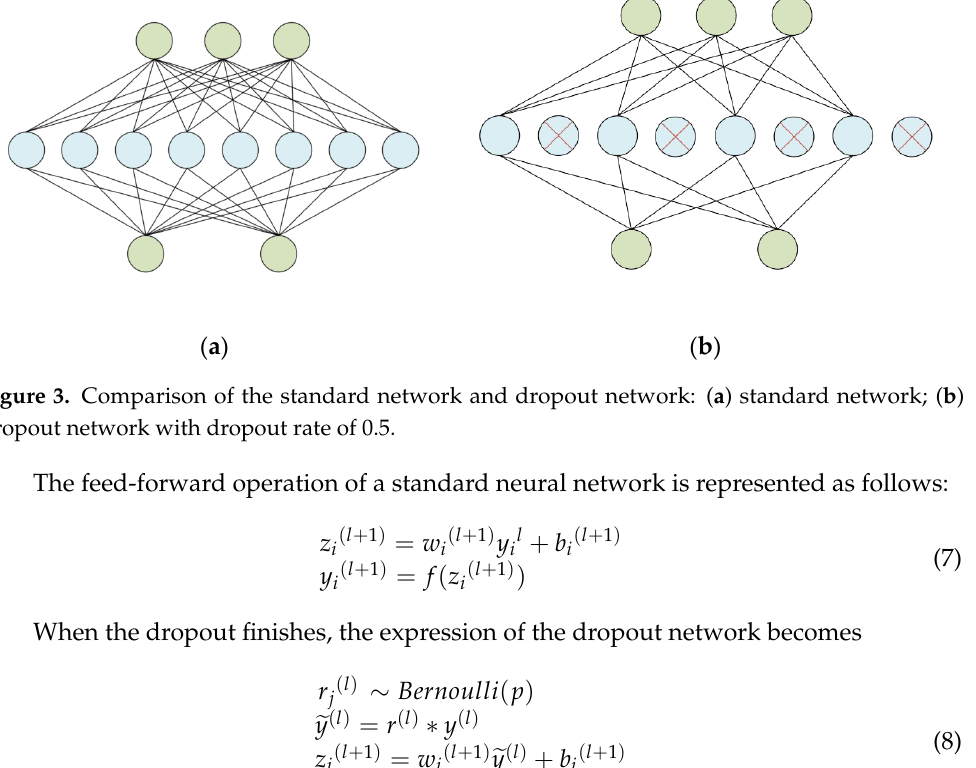
Figure 2. Improved residual block.